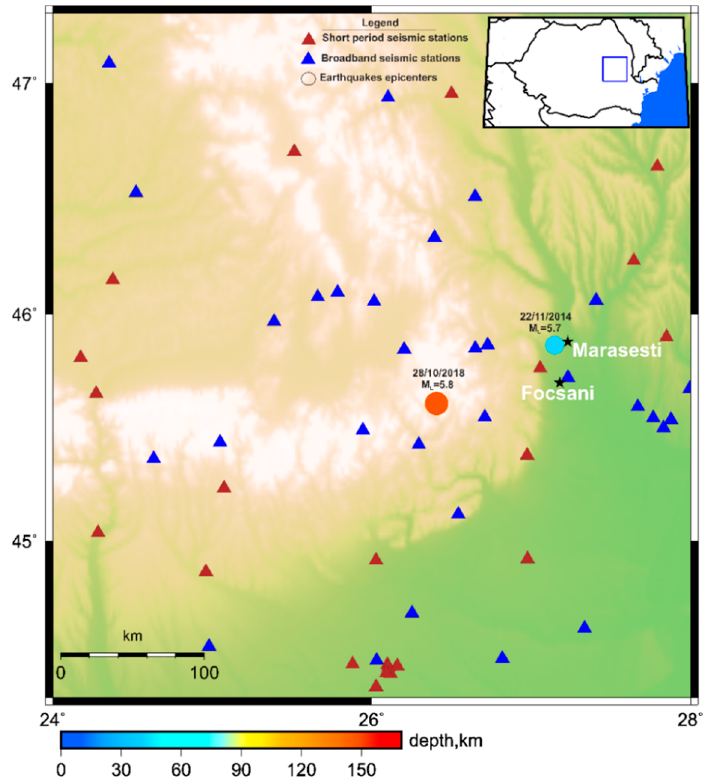
Figure 3. Epicenters of the selected earthquakes and seismic station distribution in the epicentral region. The symbols of the two earthquakes are colored according to depth, and their size is proportional to magnitude. Cities near the epicenters are represented with black symbols. The inset shows the location of the study region on the map of Romania.